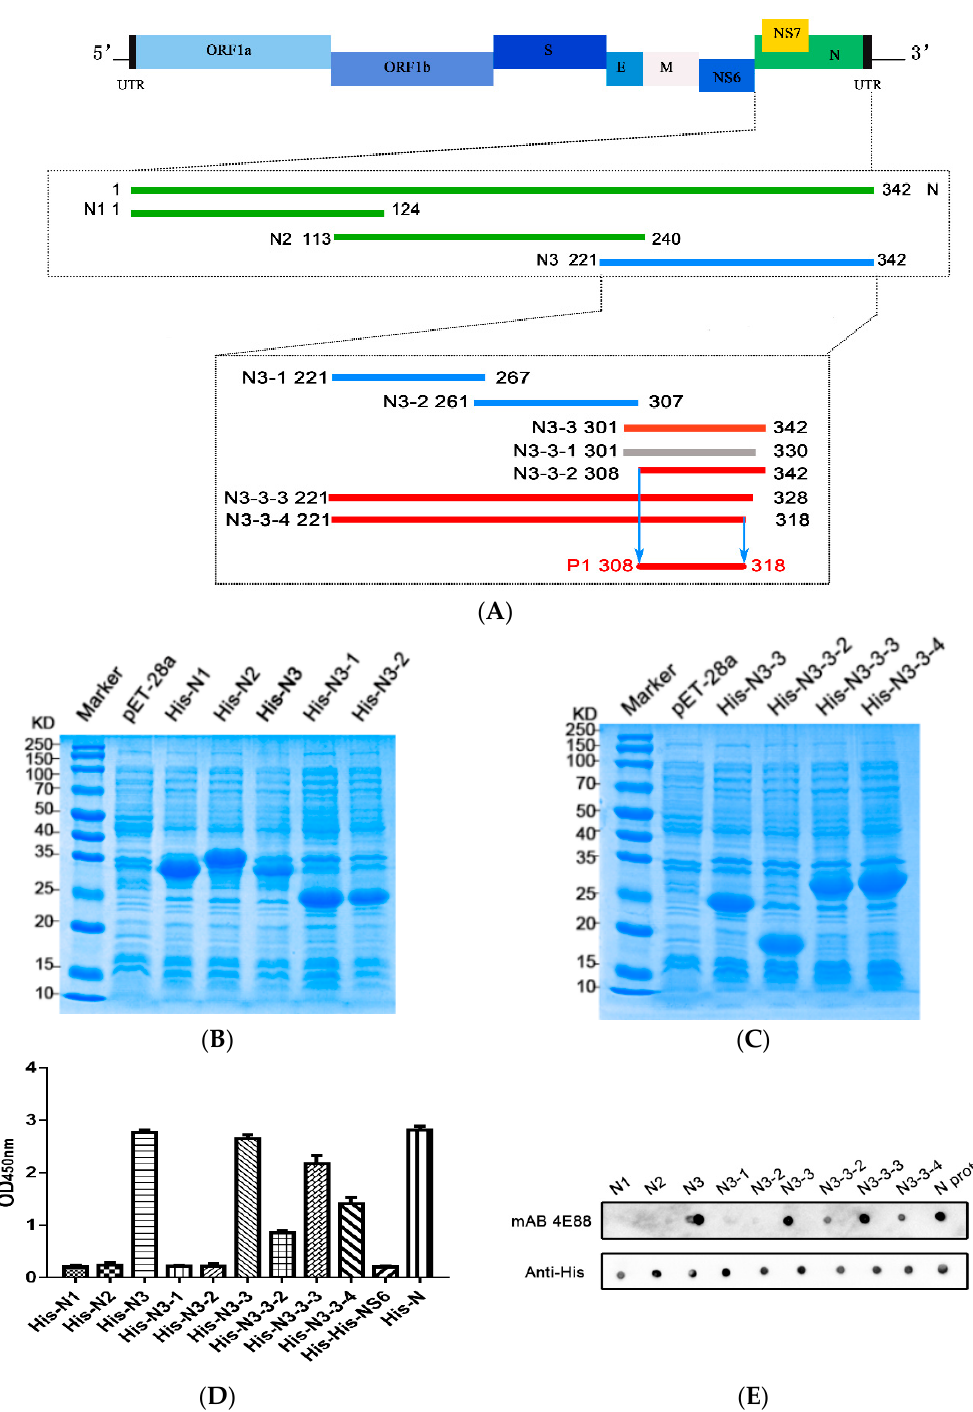
Figure 3. PDCoV N-protein epitope mapping. ( A ) Schematic of PDCoV genome organization and N-protein epitope mapping. The segments recognized by monoclonal 4E88 are represented by red lines, the segments unrecognized by 4E88 are represented by green and blue lines, and the segment that was unsuccessfully expressed is represented by gray; ( B , C ) SDS-PAGE of the N-protein truncations expressed in E. coli ; ( D , E ) ELISA and dot blot assays of the reactivity of monoclonal 4E88 with the N-protein truncations. The experiments were performed in triplicate.